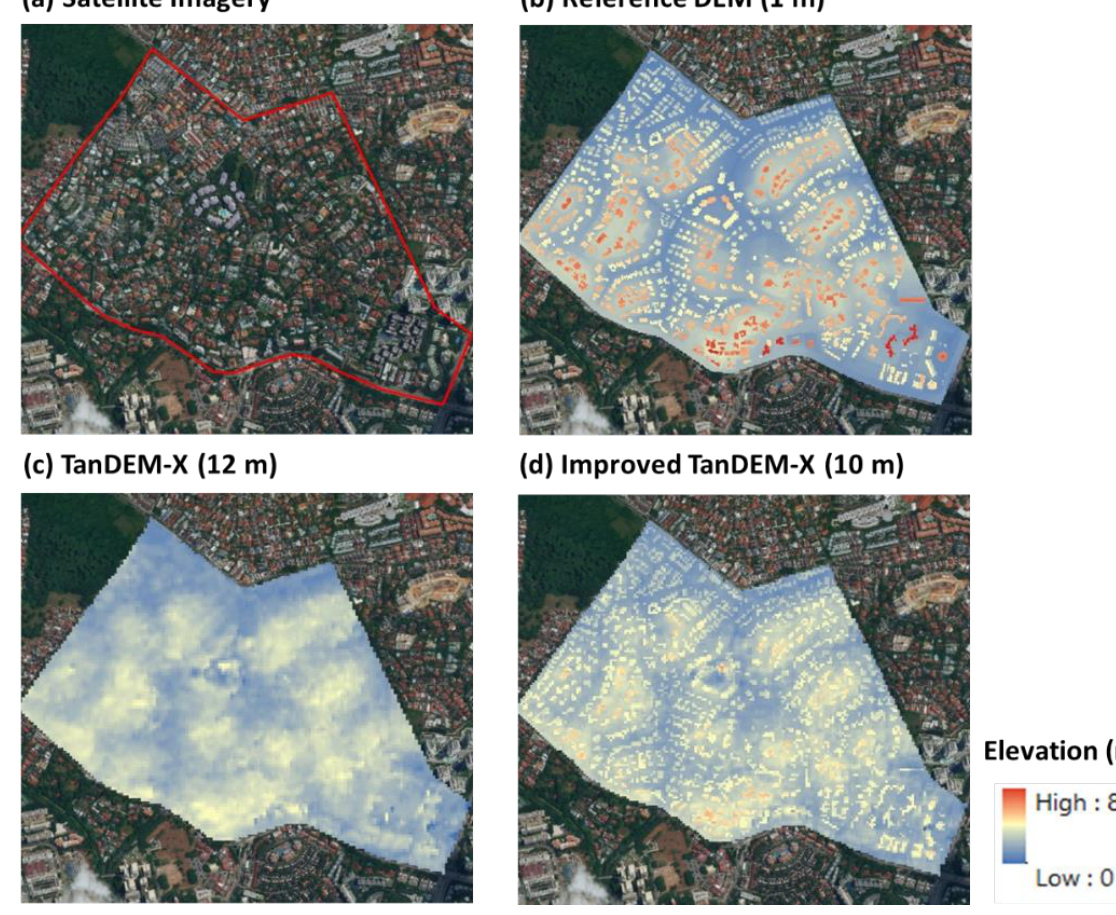
Figure 5. Visual assessment of TanDEM-X and iTanDEM-X of the urban area in Singapore: ( a ) Satellite Imagery, ( b ) Reference DEM (1 m), ( c ) TanDEM-X (12 m), ( d ) improved TanDEM-X (10 m) .